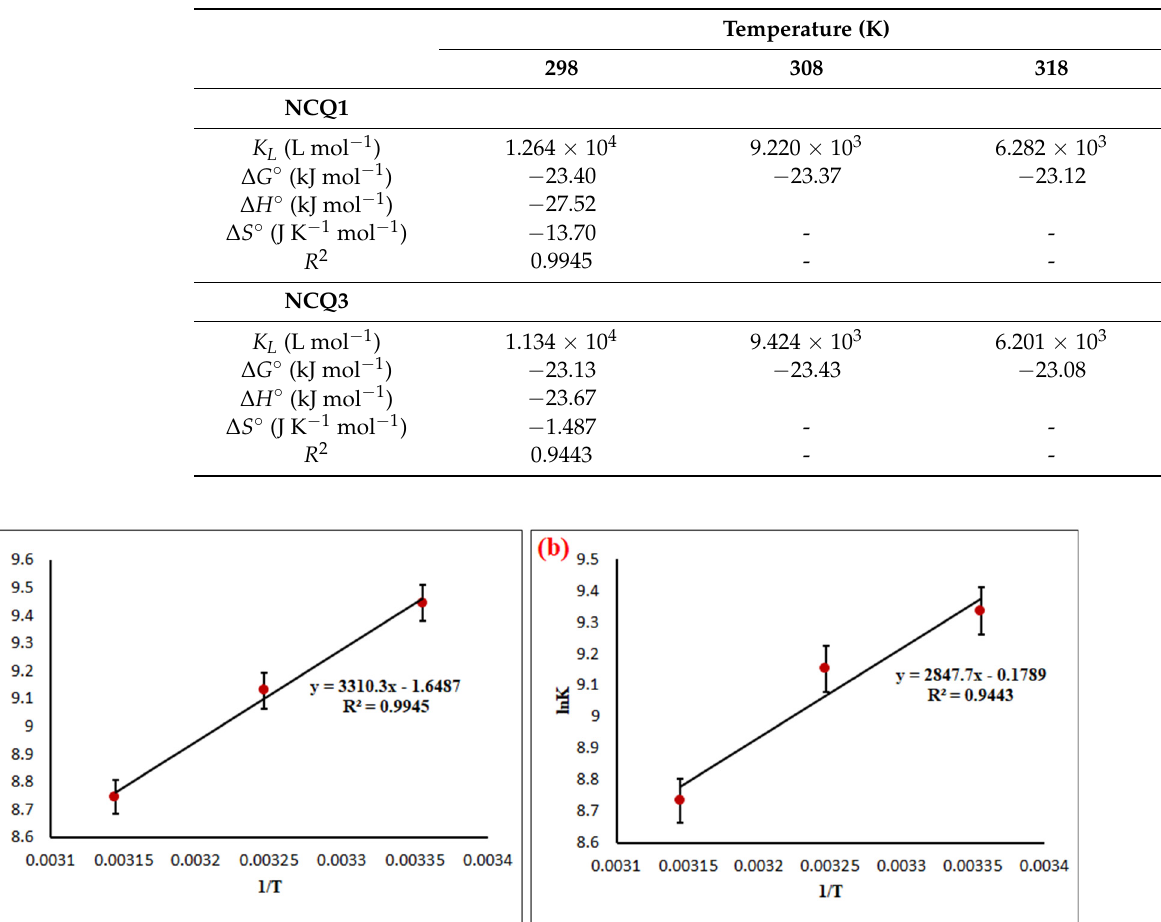
Figure 8. ( a ) Plot of lnK vs. 1/ T for thermodynamic parameters calculation for adsorption of CV dye onto NCQ1 ( b ) and NCQ3 adsorbents. Table 6. Thermodynamics factors for CV dye adsorption on both NCQ1 and NCQ3 adsorbents.